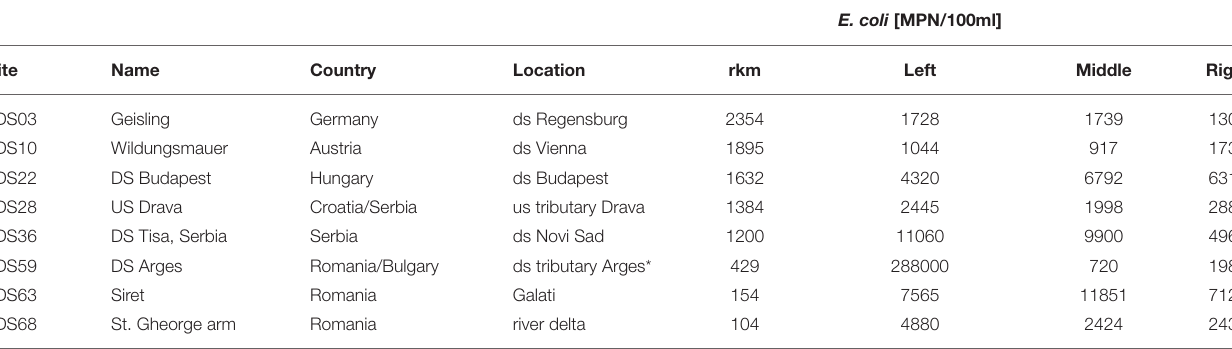
TABLE 1 | Investigated sampling sites names and numbers according to JDS3, country and detailed location (ds = downstream, us =